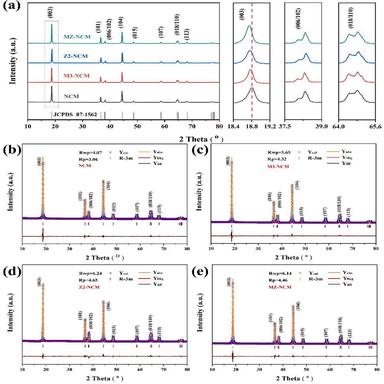
XRD patterns of (a) the four samples; Rietveld refinement results for (b) NCM, (c) M3-NCM, (d) Z2-NCM and (e) MZ-NCM.